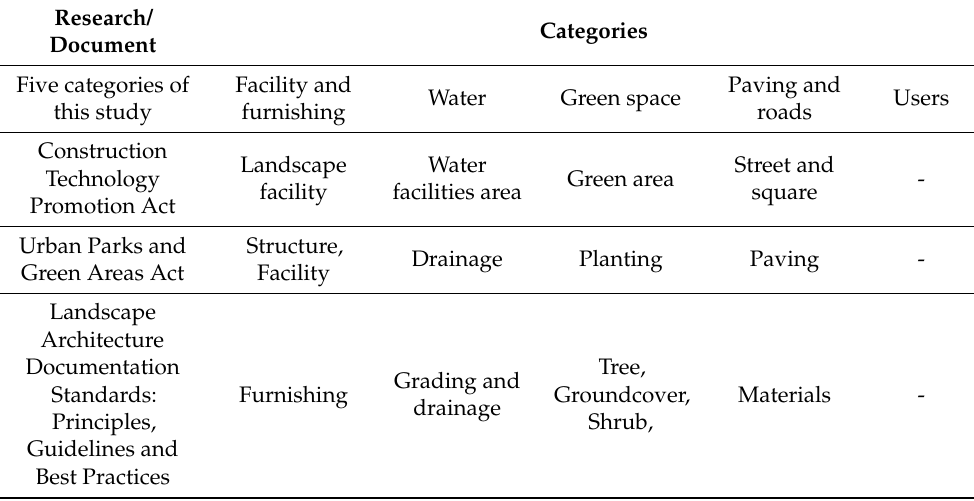
Table 5. Category of the park